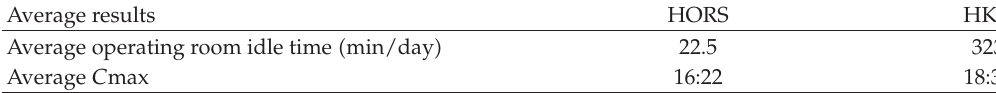
Table 3: Average results of 12 samples examined.